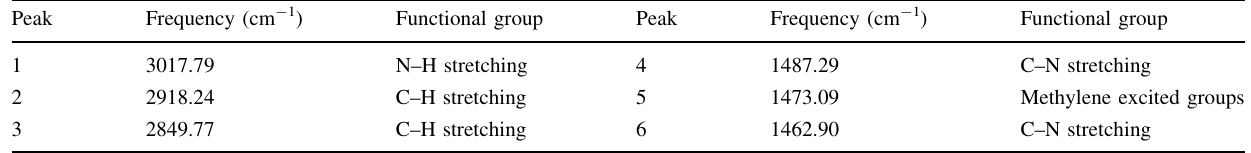
Table 3 Characteristic peaks and functional groups of CTAB in FTIR spectrum